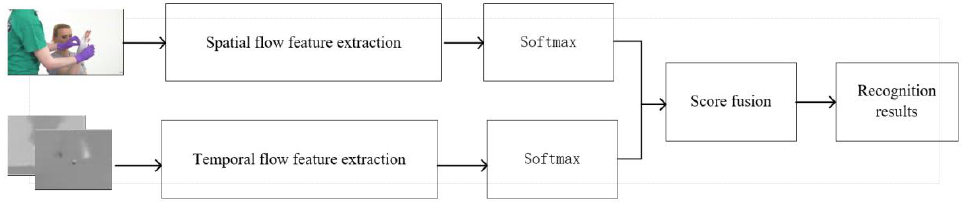
Figure 8. Late fusion